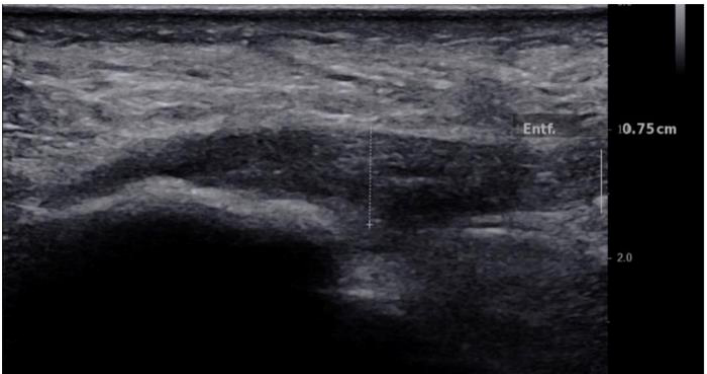
Figure 1. Longitudinal B-mode ultrasound image of a 50-year-old patient with plantar fascia shows hypoechogenicity and thickening of the plantar fascia of 7 mm.